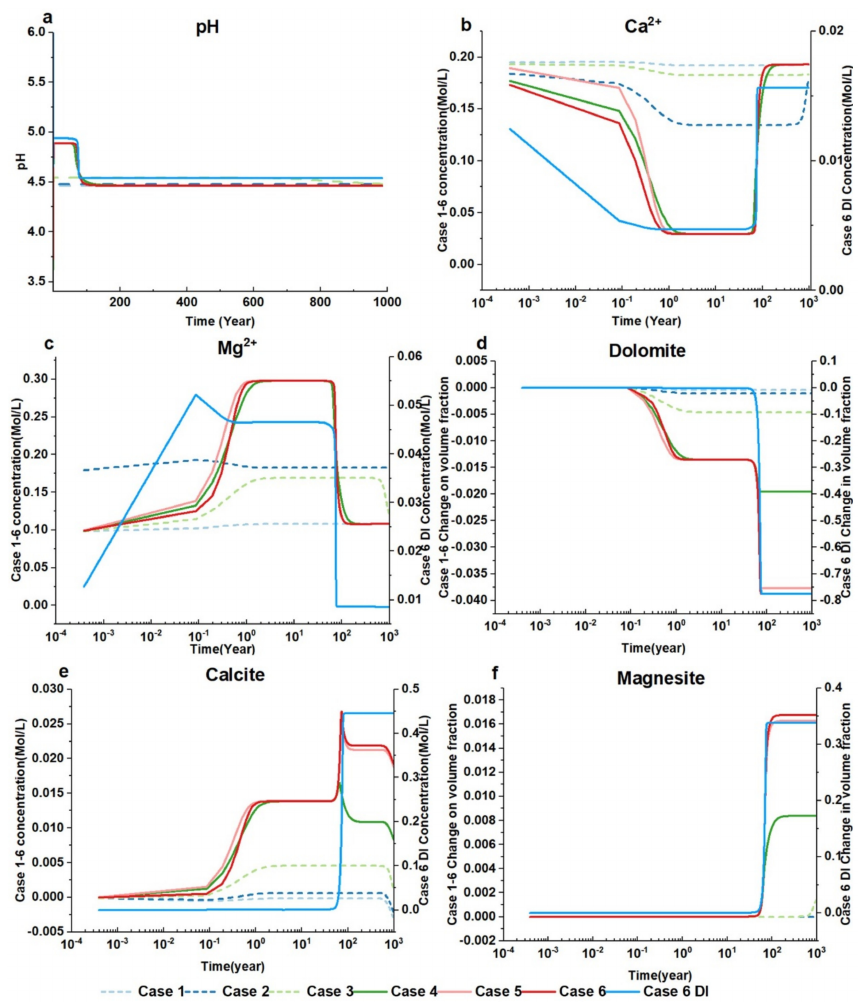
Figure 12. The variations of pH ( a ), Ca 2+ and Mg 2+ concentrations ( b , c ). The abundance changes of dolomite ( d ), calcite ( e ), and magnesite ( f